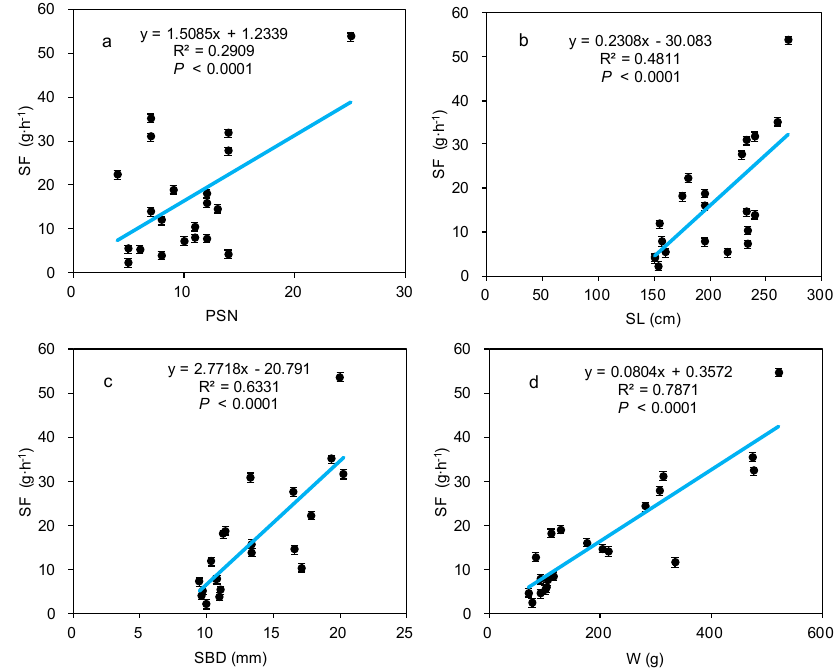
Figure 7. Regression relationships between the stem-scale SF and stem morphological traits.